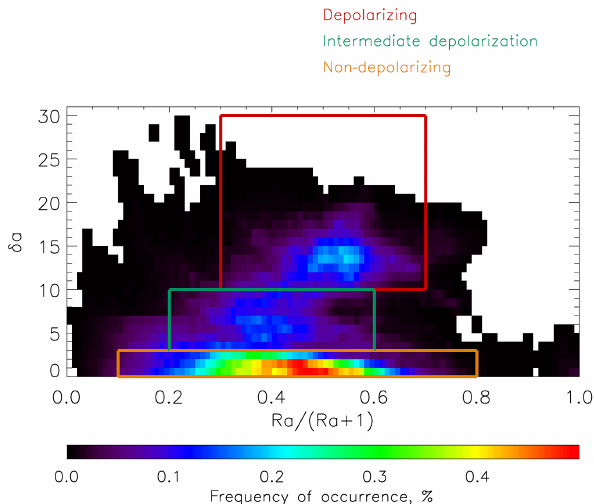
Figure 1. Probability density function of aerosol particle optical properties over 15 June–5 July 2012 as a function of R a /(R a + 1 ) and δ a parameters. The colour code indicates the frequency of oc-